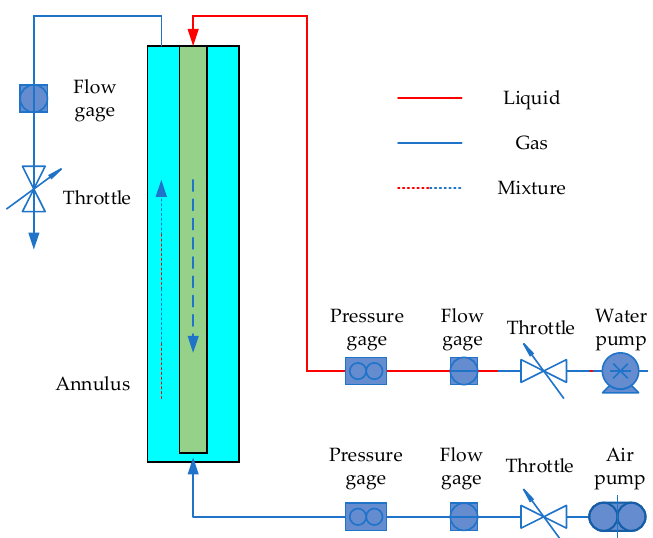
Figure 4. Schematic diagram of experimental equipment.